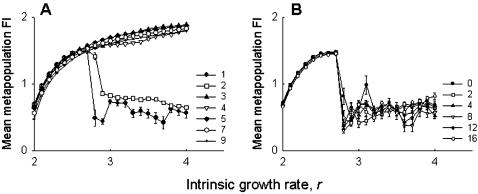
Simulations with no extinctions: effect of pinning density and magnitude on stability. (A) When there are no extinctions, increasing the number of pinned patches was generally found to destabilize the metapopulation dynamics, similar to the experimental scenario (5A). (B) Changing the strength of pinning, however, did not affect the metapopulation stability, although there was a change in the FI profile relative to the earlier simulations incorporating extinctions (cf. Fig 5B).